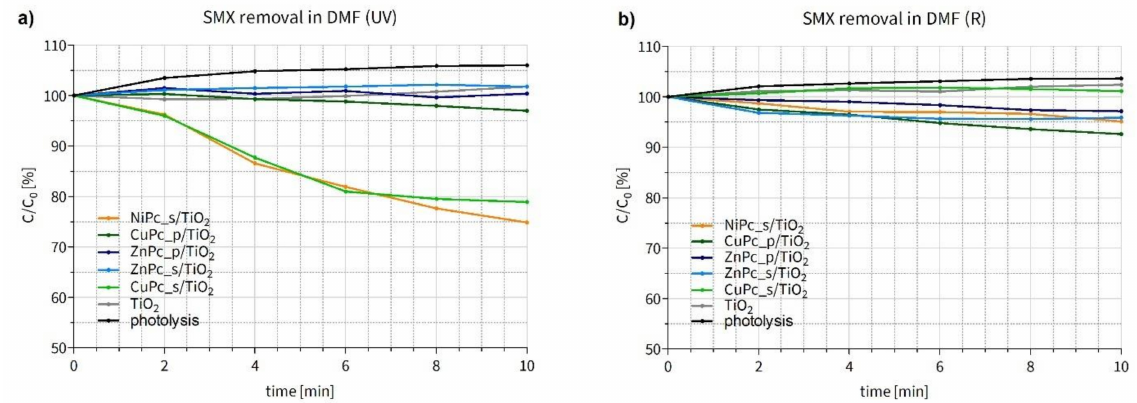
Figure 13. Changes in sulfamethoxazole concentration after ( a ) UV irradiation (365 nm light) ( b ) after R irradiation (665 nm light) of the DMF suspension containing a photocatalyst. The trend observed for SMX photolysis is the result of dynamic interactions between SMX molecules and DMF under irradiation conditions. Over the experiment time, SMX molecules formed associates with DMF (the absorbance values in UV-Vis measurements increased and reached